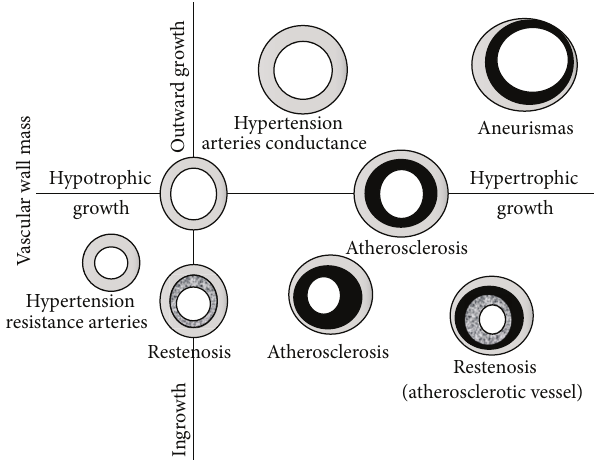
Figure 2: Schematic representation for the adaptation of these changes in different pathologies, including structural changes to the intima layer that contribute to remodeling of the vascular wall. Thus, outward remodeling compensates for atherosclerotic plaque growth and delays the progression of blood flow limitation during stenosis, whereas during restenosis, intimal hyperplasia causes a narrowing of the